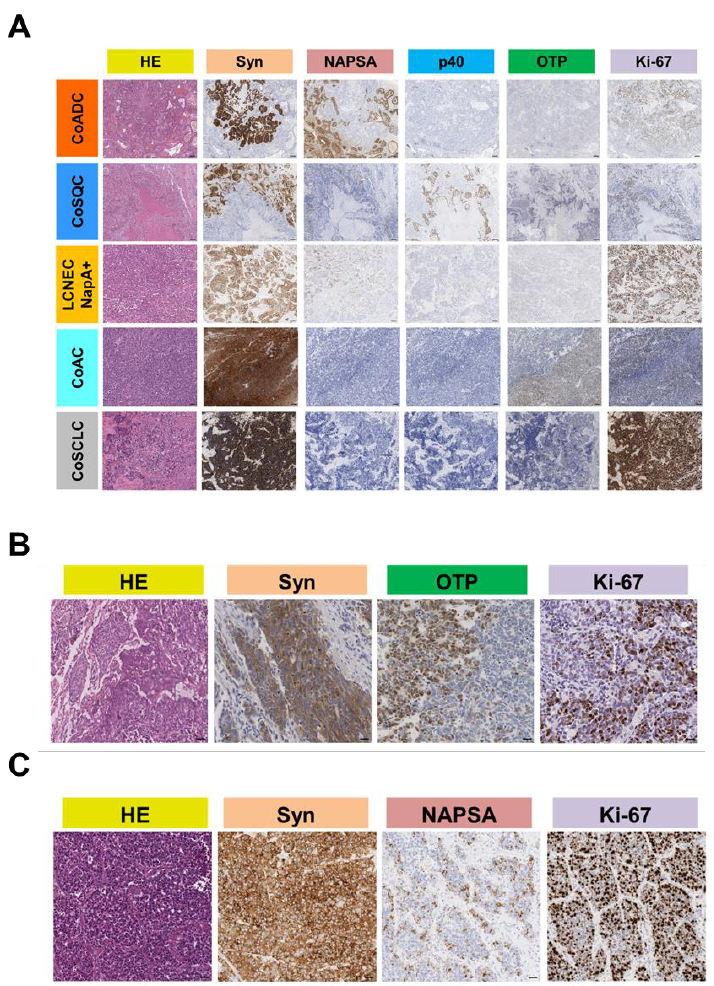
Figure 1. ( A ) Representative cases of combined-LCNEC. Histopathological features of the different components in five selected cases of combined large cell neuroendocrine carcinomas (combined- LCNEC). CoADC, combined-LCNEC with adenocarcinoma; CoSQC, combined-LCNEC with squa- mous cell carcinoma; LCNEC NapA+, LCNECs showing only immunohistochemical napsin-A pos- itivity but no evidence of a distinct conventional ADC pattern; CoAC combined-LCNEC with atyp- ical carcinoid; CoSCLC, combined-LCNEC with small cell neuroendocrine carcinoma. HE (hema- toxylin and eosin); Syn (synaptophysin); NAPSA (napsin-A); p40 (deltaNp63); OTP (orthopedia homeobox protein); Ki-67 (MIB- 1); Scale bar = 100 μm. Syn immunostaining identifies the AC, SCLC and LCNEC components, while NAPSA identifies the adenocarcinoma and p40 the squamous com- ponent. ( B ) Representative case of CoAC. Ki-67 immunostaining was different between the AC and LCNEC; Scale bar = 50 μm . ( C ) Representative case of LCNEC NapA+. Napsin-A identified exocrine areas; Scale bar = 50 μm.